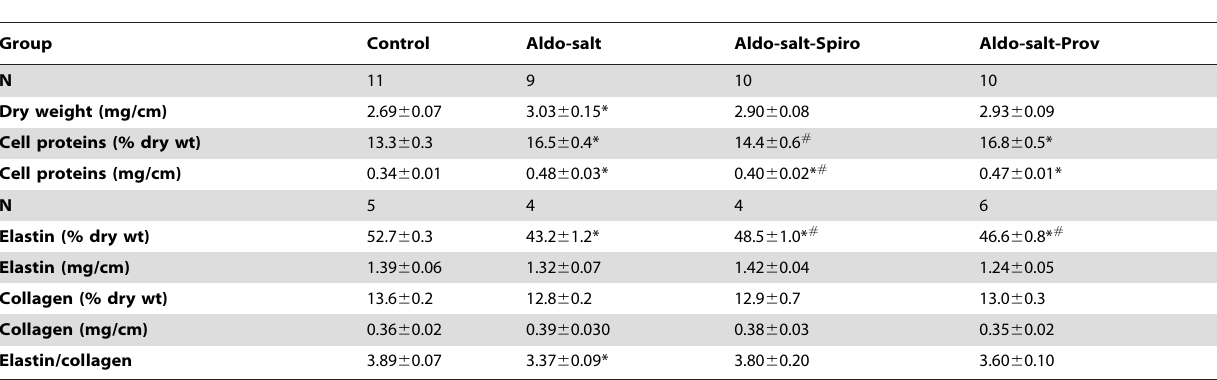
Table 2. Effects of treatment by Spironolactone (Spiro) or Provinols TM (Prov) on aortic medial composition in aldosterone-salt (Aldo-salt) treated